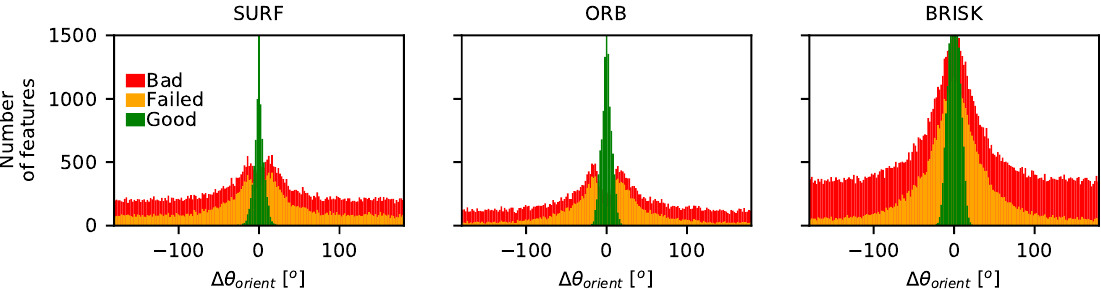
Figure 10. Histogram showing the numbers of features successfully matched (good), those incorrectly matched (bad), and those that failed to match (failed) versus the difference in the calculated feature orientation (after correction for applied rotation). Results shown here are for the stepped rotation data set using the flat lapping reaming ( R z = 1.6 µ m) surface finish; however, similar results are found for other